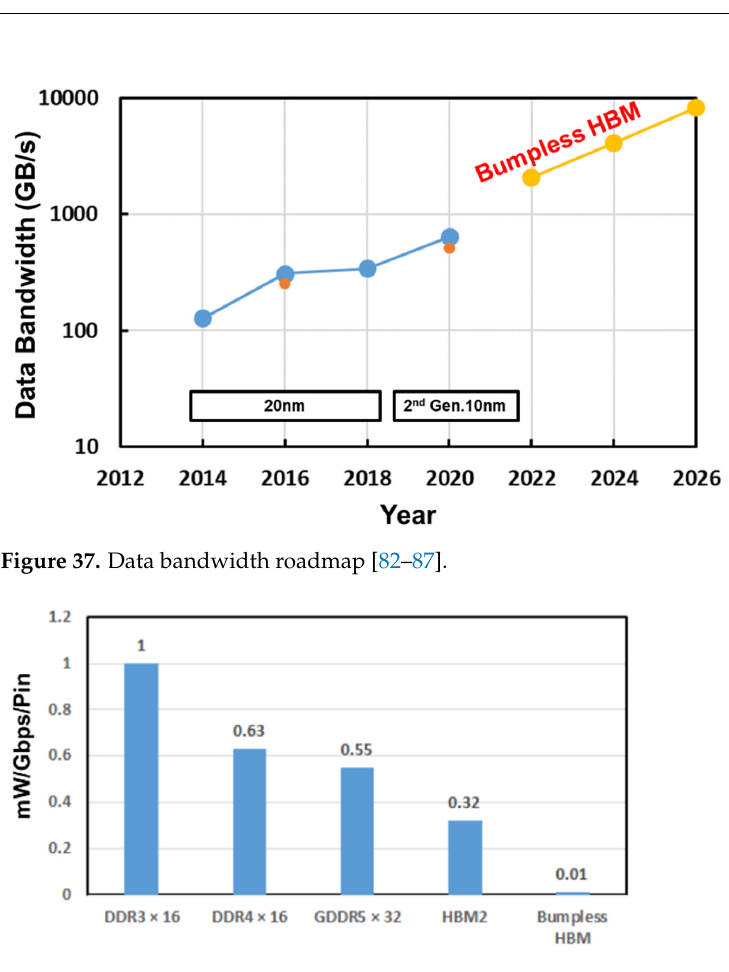
Figure 38. I/O power efficiency.